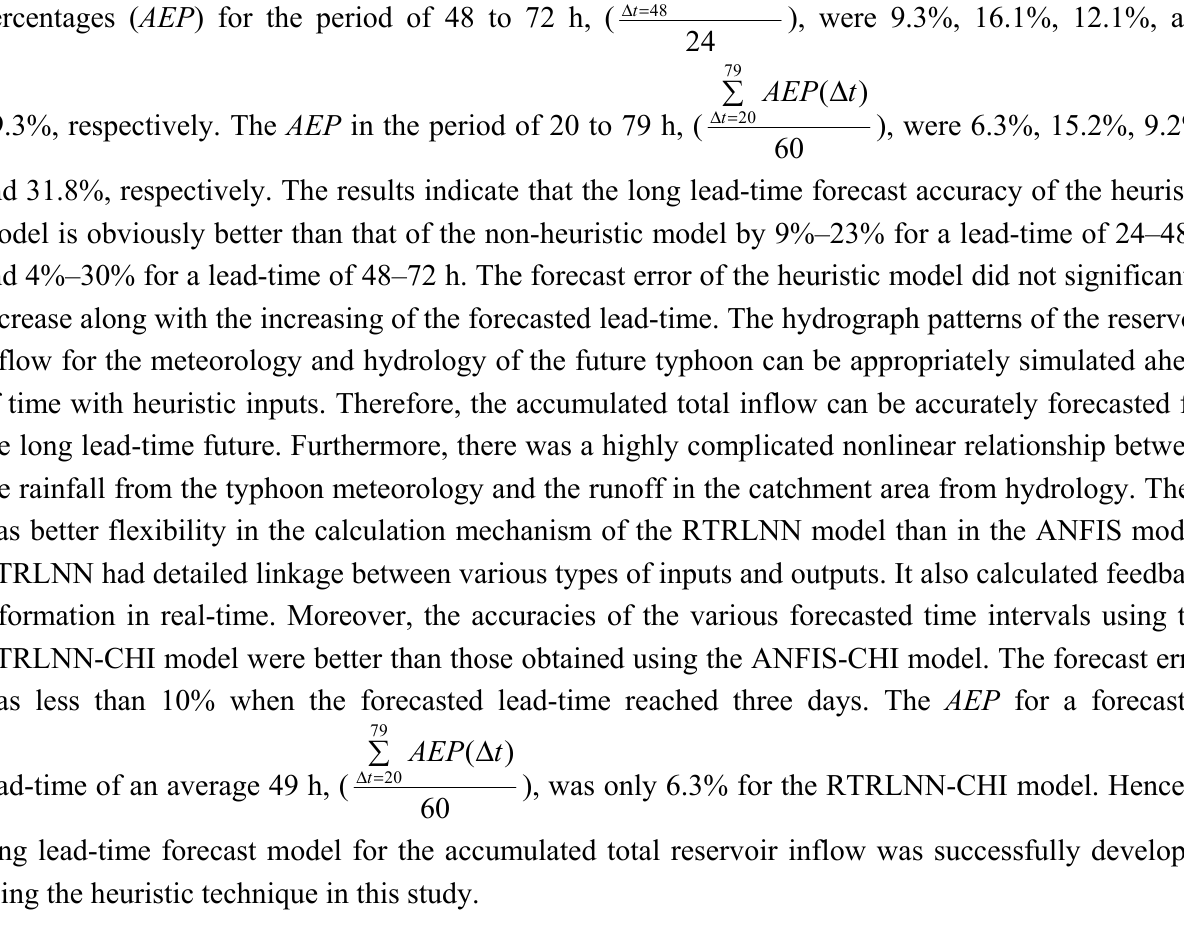
Table 3. Average error percentage of the four developed models across long lead-times.